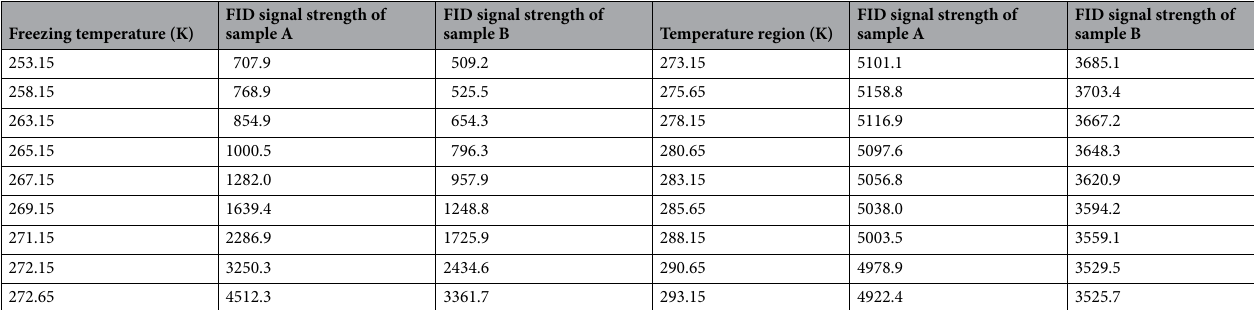
Table 1. FID signal amplitudes at different freezing temperatures.